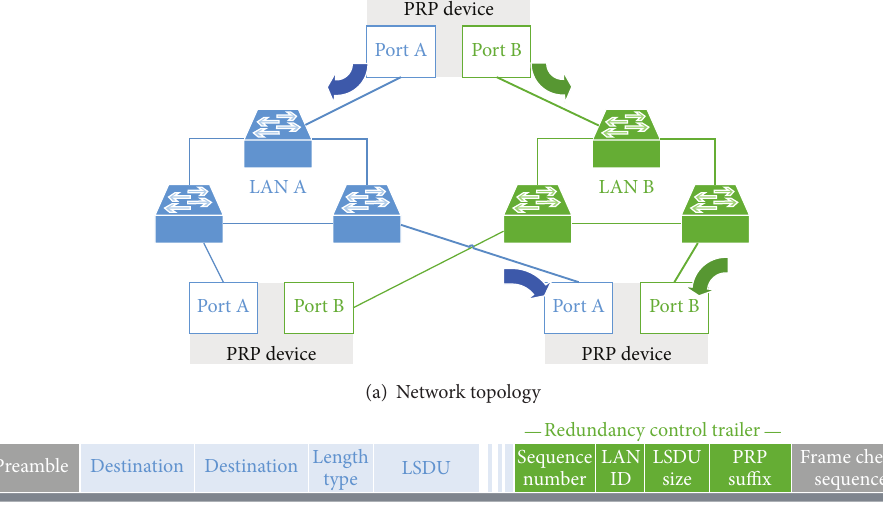
Figure 2: PRP operation process and